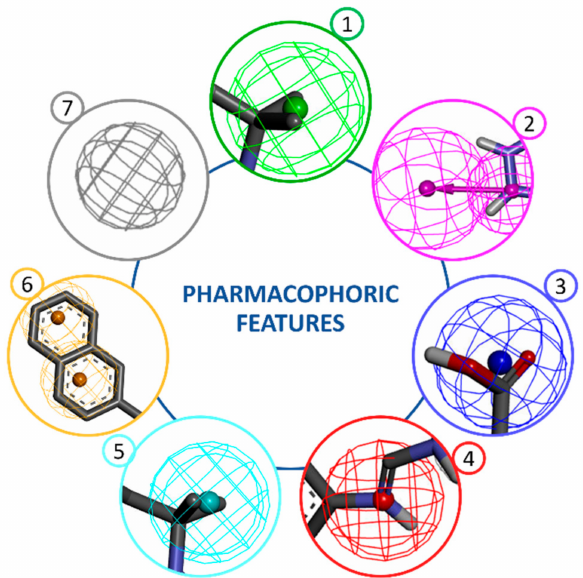
Figure 1. Pharmacophoric features. Main pharmacophoric feature types are represented by geo- metric entities and include: 1—hydrogen bond acceptor (HBA), 2—hydrogen bond donor (HBD), 3—negative ionizable (NI), 4—positive ionizable (PI), 5—hydrophobic (H), 6—aromatic (AR), 7—exclusion volume